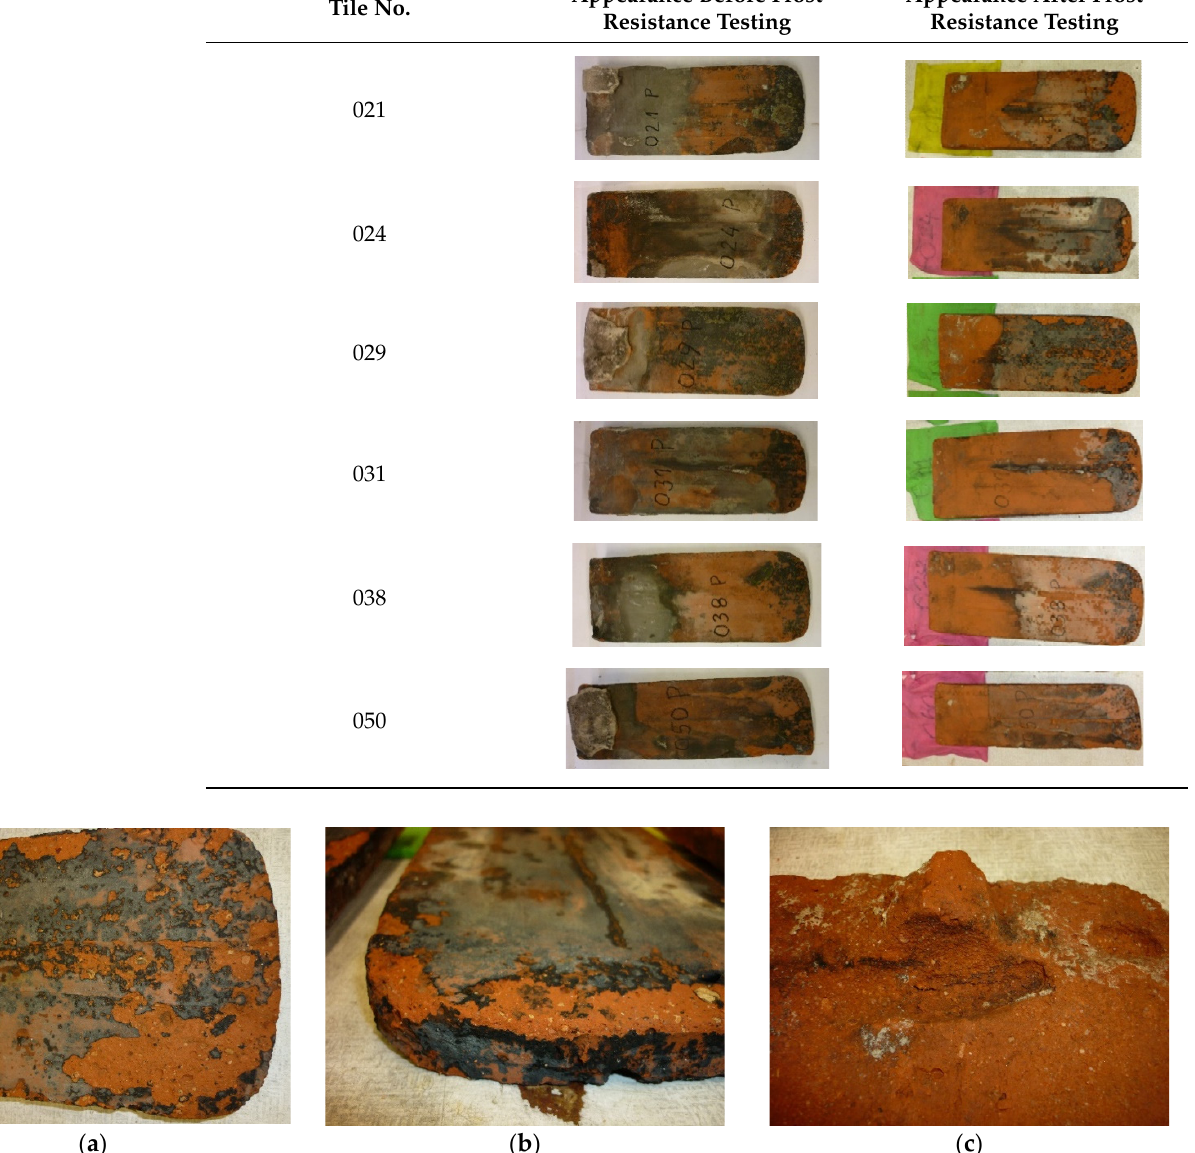
( b ) Figure 9. Roof tiles during the impermeability test: ( a ) general view; ( b ) view of the underside of tile. The test results for the individual tiles and the time to the first drop of water (h) are shown in Figure 10. The average time to the first drop of water for the entire test series was X i av = 4.98 h. The highest value of the single water absorption coefficient was ICX i av = 0.751. The mean permeation coefficient was ICX i av = 0.751. The value of the largest single- sample permeation coefficient was ICX i = 0.988.